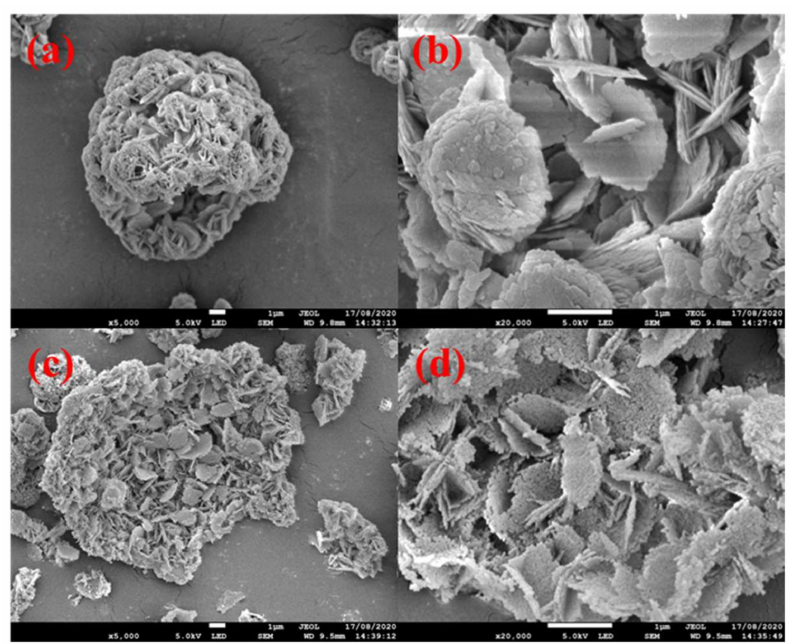
Figure 9. ( a , b ) SEM images of 4MgCO 3 · Mg(OH) 2 · 4H 2 O, ( c , d ) SEM images of MgO.